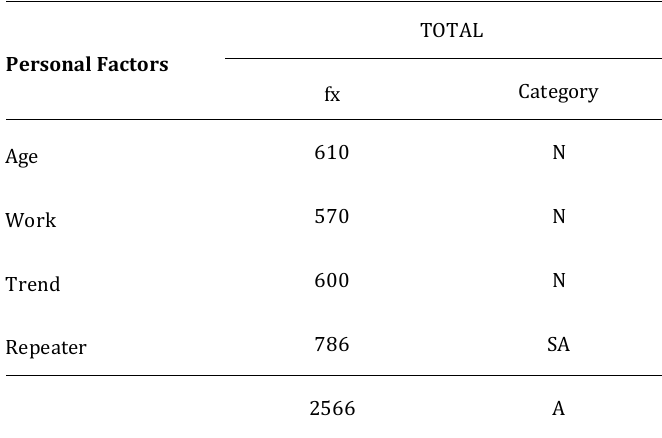
Table 4 Data analysis of personal